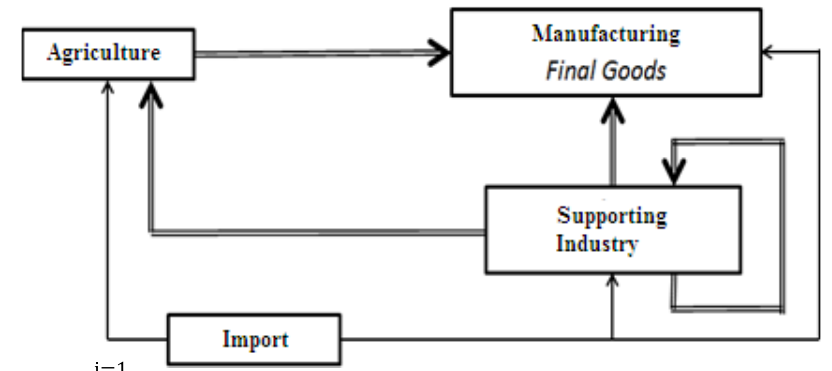
Figure 1: The Linkage between Agriculture and